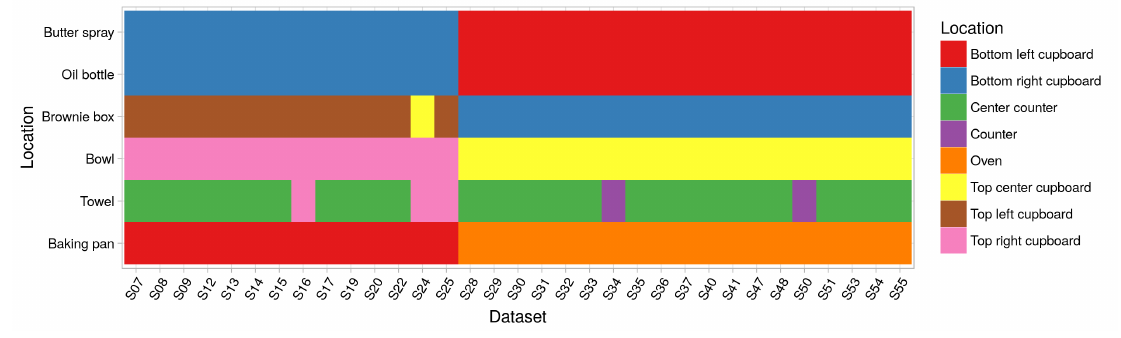
Figure 10. The different initial locations of some objects. It can be seen that, from S28, the locations of most objects were changed at the beginning of the experiment. The towel, for instance, was placed at the center of the counter except for five datasets where the towel was either on the other counter or a cupboard.